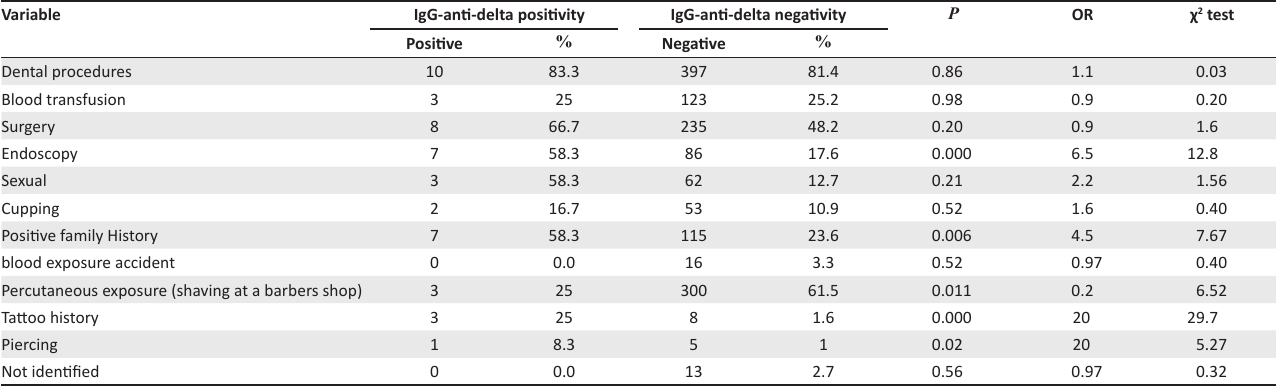
TABLE 3: Relationship with risk factors and hepatitis delta virus. Variable